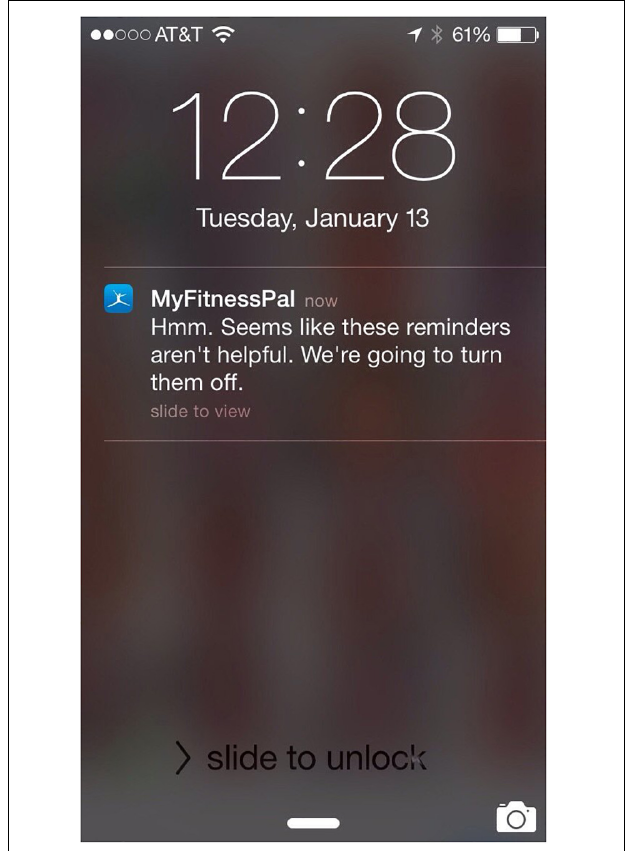
FIGURE 4 | MyFitnessPal coaching feature turning off after not logging in for a few